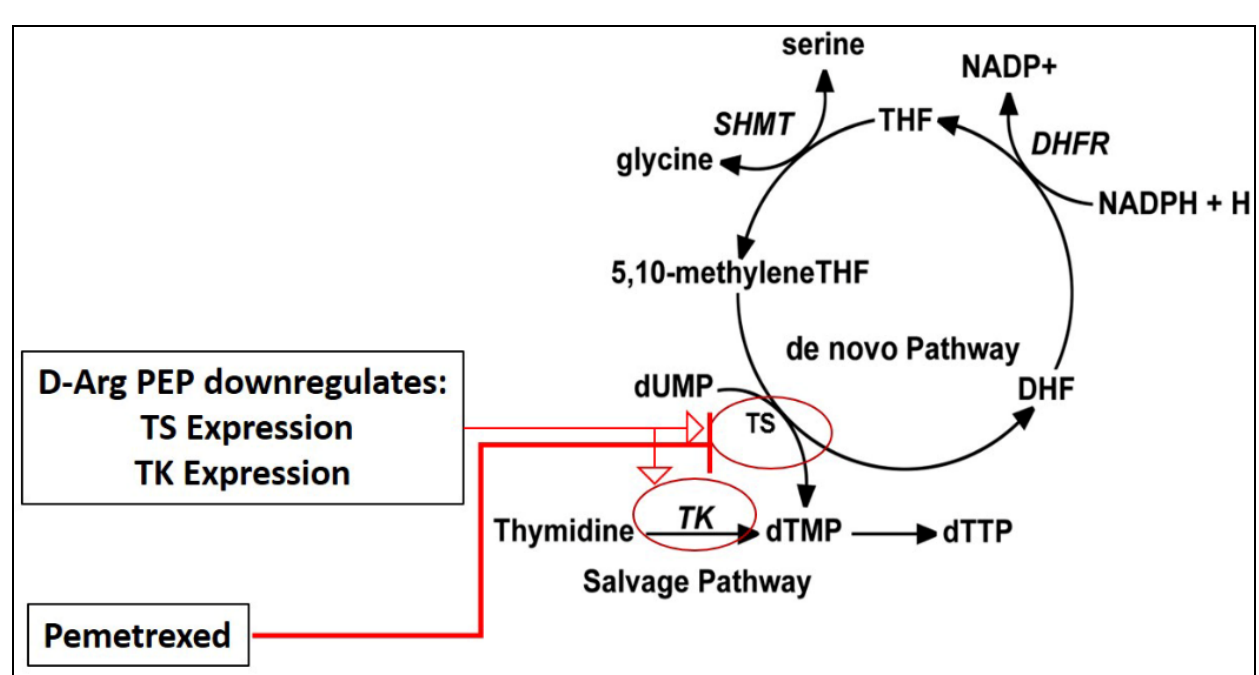
Figure 1. Schematic diagram showing D-Arg PEP and pemetrexed combination rationale. D-Arg PEP downregulates thymidylate synthase (TS) and thymidine kinase (TK) expression, and pemetrexed is a potent TS inhibitor.